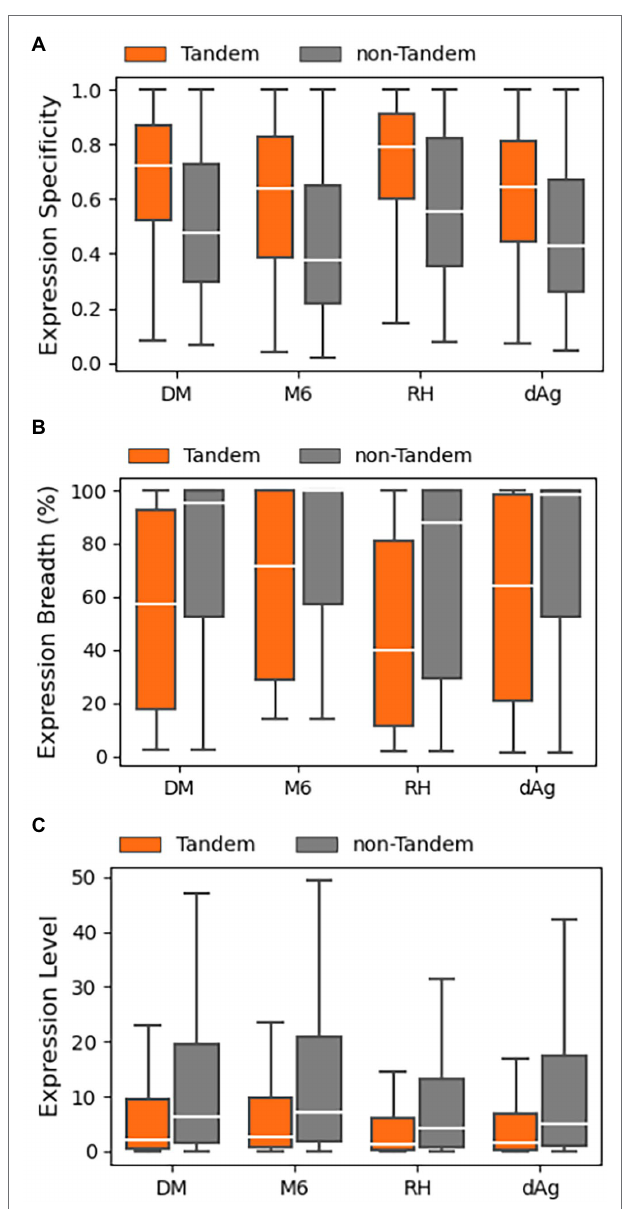
FIGURE 5 | Expression patterns of tandemly duplicated genes in DM, M6, RH, and dAg. (A) Expression Specificity, (B) Expression Breadth (%), and (C) Expression